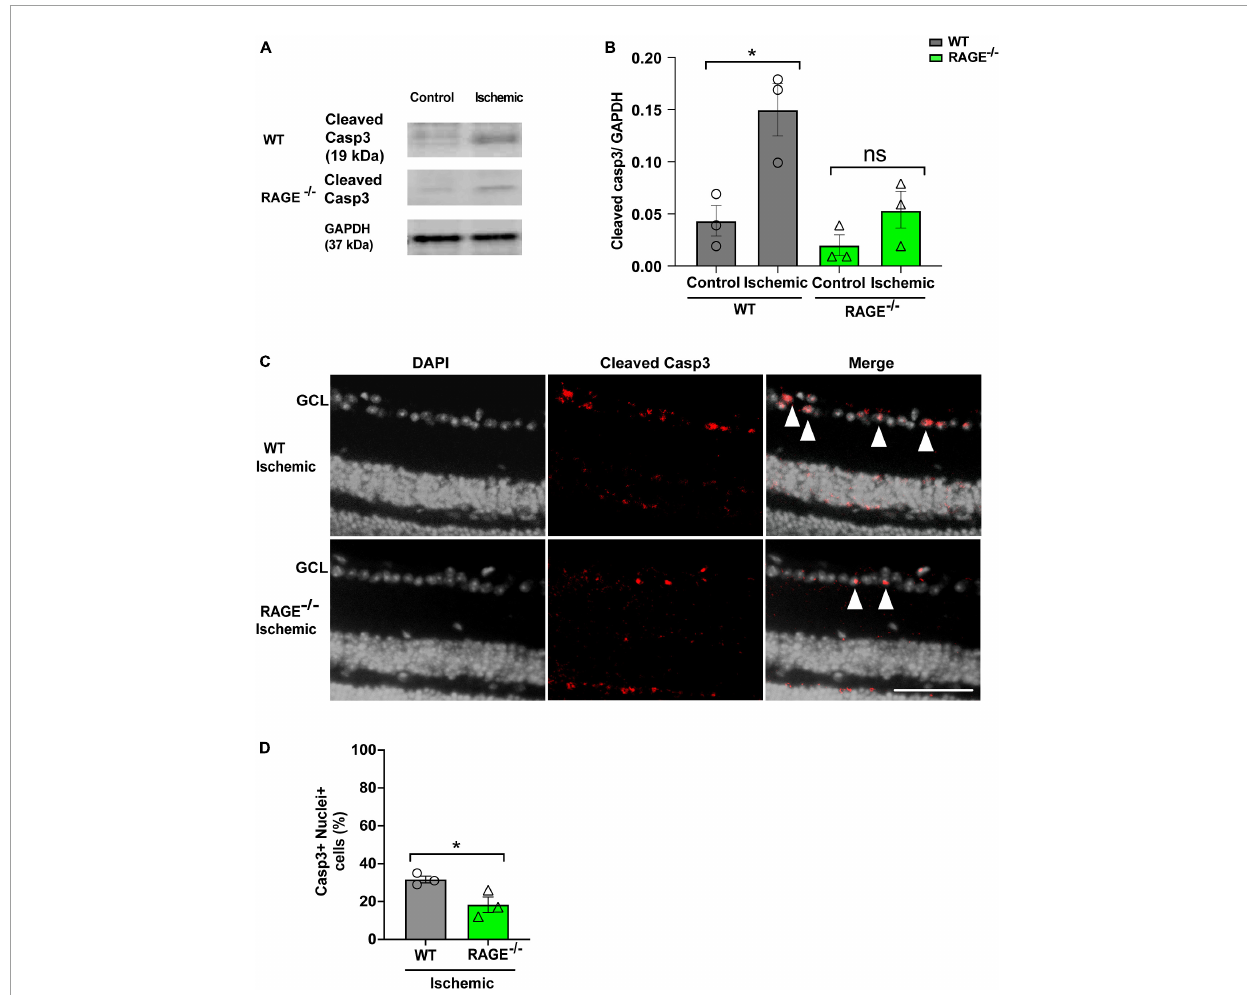
FIGURE5 Assessment of apoptotic cell death in the ischemic group. (A,B) Western blotting of cleaved caspase 3 (19kDa) in control and ischemic retinas of WT and RAGE − / − mice. GAPDH was used as a control, followed by quantification of cleaved casp3 in animal groups using densitometry ( n = 3). (C) Immunostaining shows a co-staining of cleaved casp3 (red) and the nuclei (gray) in the GCL of ischemic WT and RAGE − / − groups ( n = 3). (D) Quantification represents a significant increase in the density of casp3 + nuclei + cells in the WT ischemic group, compared to RAGE − / − mice. * p = 0.02, * p = 0.04, ns: no significance unpaired t- test. The scale bar is 100 µ